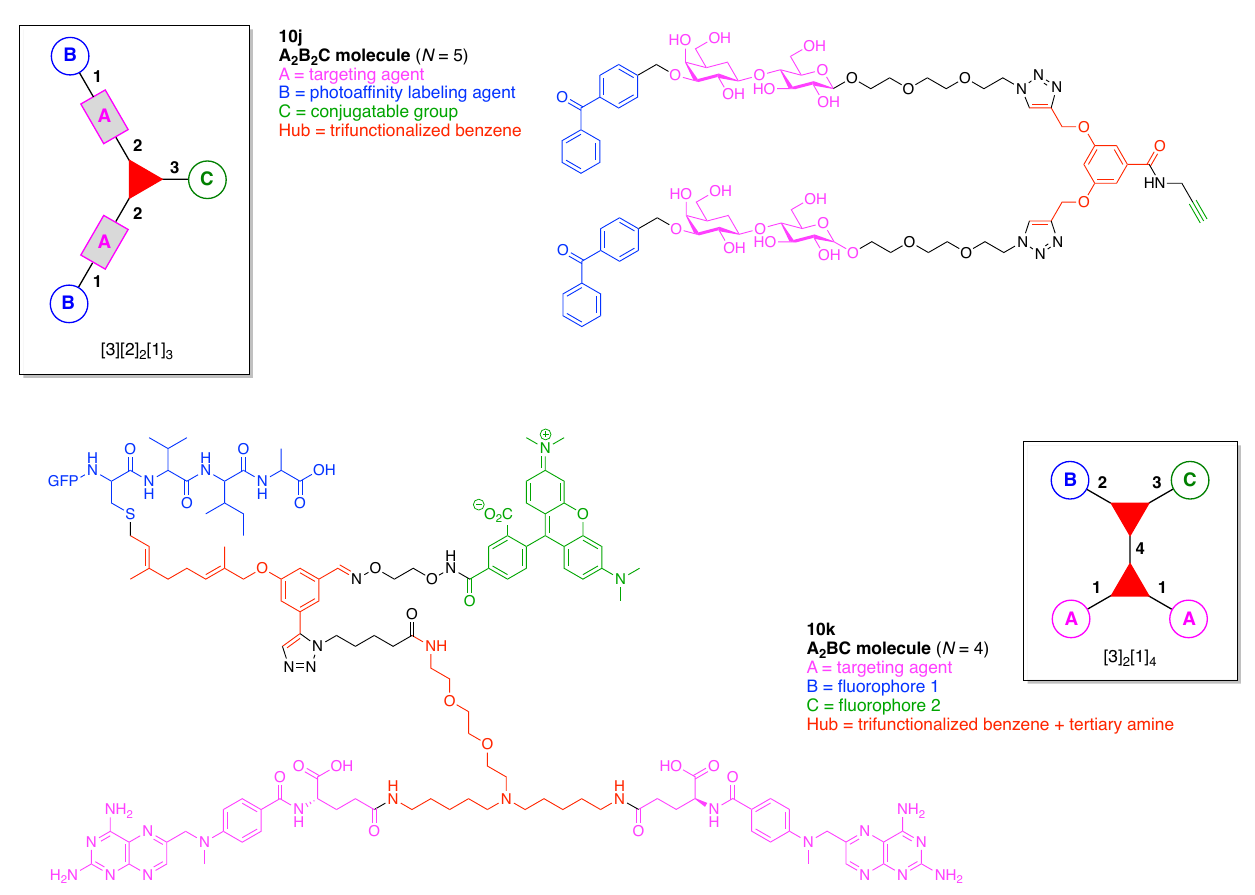
Figure 49. Examples wherein each contains one or two benzene hubs.